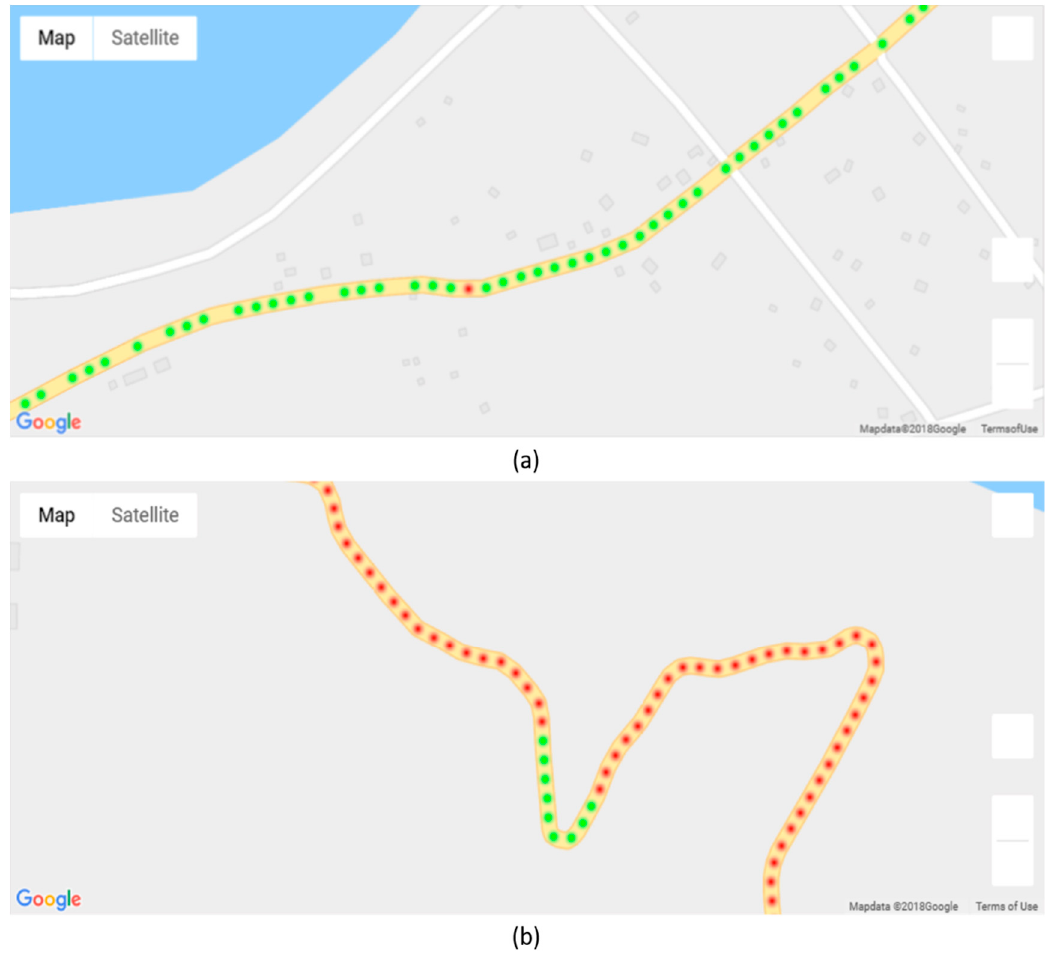
Figure 20. Result of maps visualization: ( a ) paved roads and ( b ) unpaved roads.